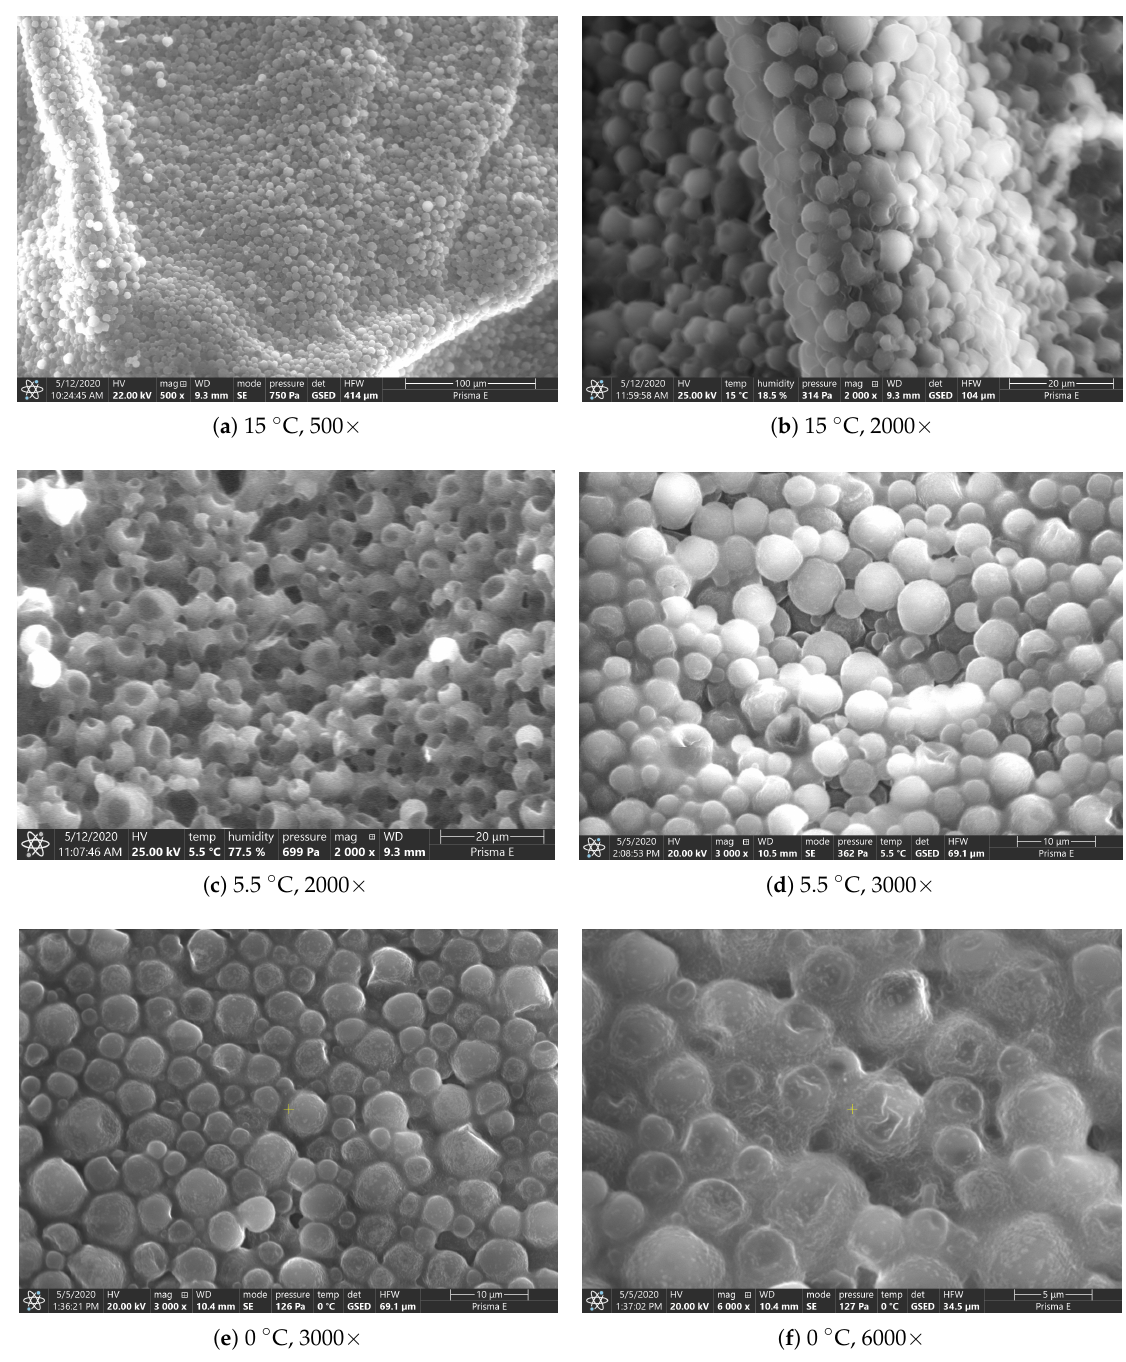
Figure 3. Analysis of the PCM internal structure, made for different temperatures and magnifications obtained while using the